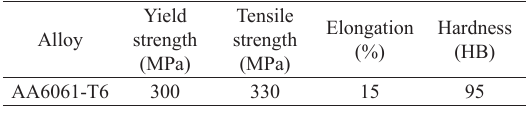
Table 1. Mechanical properties of the as-received AA6061-T6 aluminium alloy 15 .